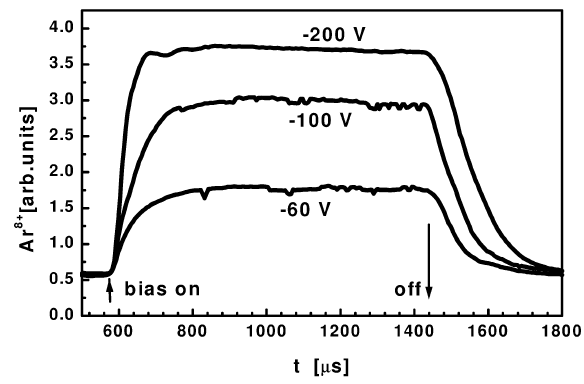
FIG. 5. Time structure of the extracted ion pulses for different charge sates from a pure argon plasma. The amplitude of the biased-disk voltage was 2 300 V.